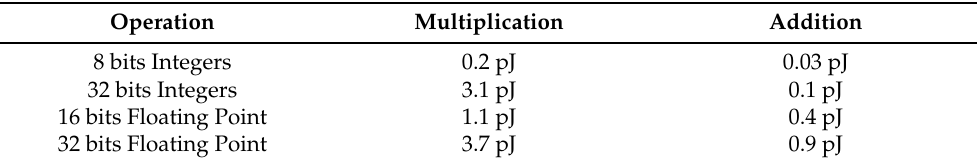
Figure 1. The entire compression flow. Table 1. Breakdown of the energy consumption for multiply-accumulate operations [5]. Adapted with permission from ref. [5]. Copyright 2014 IEEE.